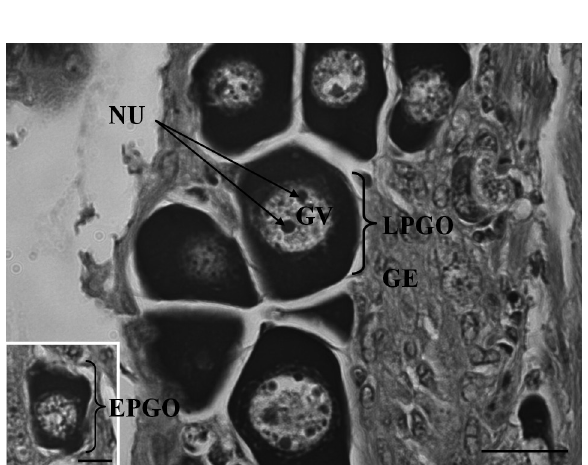
Fig . 3. – Early primary growth stage oocyte (inset) and late primary growth stage oocytes. EPGO, early primary growth stage oocyte, GE, germinal epithelium, GV, germinal vesicle, LPGO, late pri- mary growth stage oocyte, NU, nucleoli. Scale bars: 50 µm and 15 µm (inset).